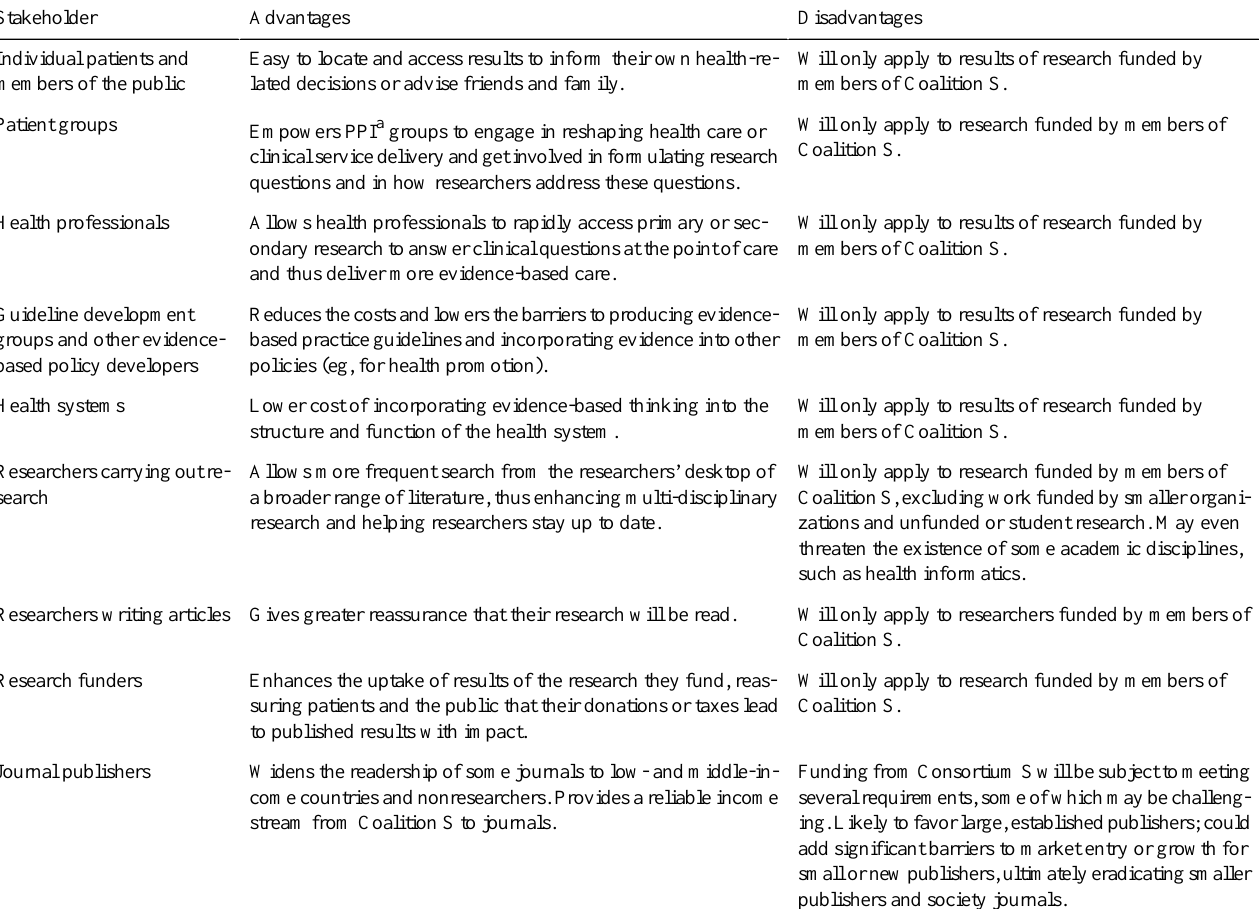
Table 1. Some advantages and disadvantages of Plan S for various stakeholders.